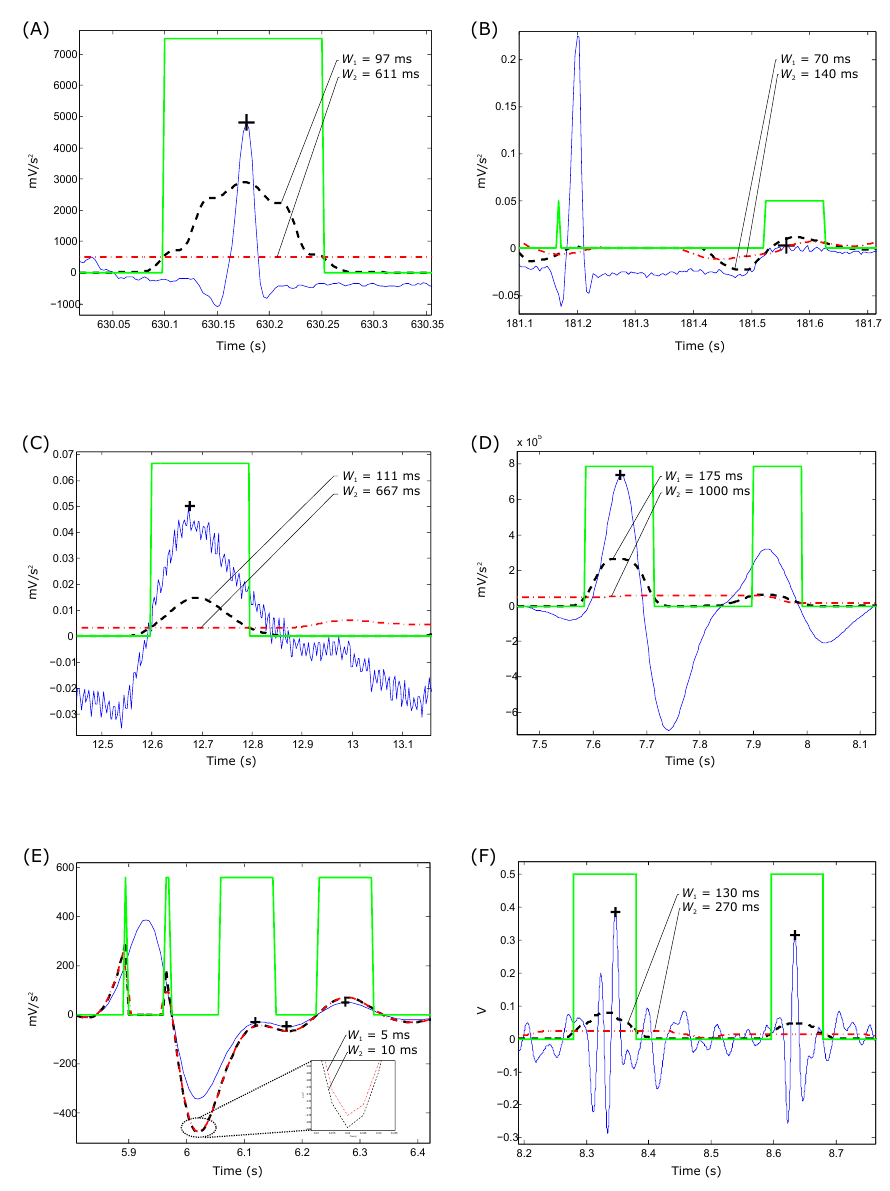
Figure 4. Demonstrating the effectiveness of TERMA in detecting events in biomedical signals. ( A ) QRS detection; ( B ) T wave detection; ( C ) systolic wave detection; ( D ) a wave detection; ( E ) c , d , and e wave detection; and ( F ) first and second heart sounds detection. The dashed black line is the MA event with W 1 , and the dotted red line is the MA cycle with W 2 . The peak of the investigated event is detected using TERMA (represented by a black plus sign) within the blocks of interest (represented by a green square